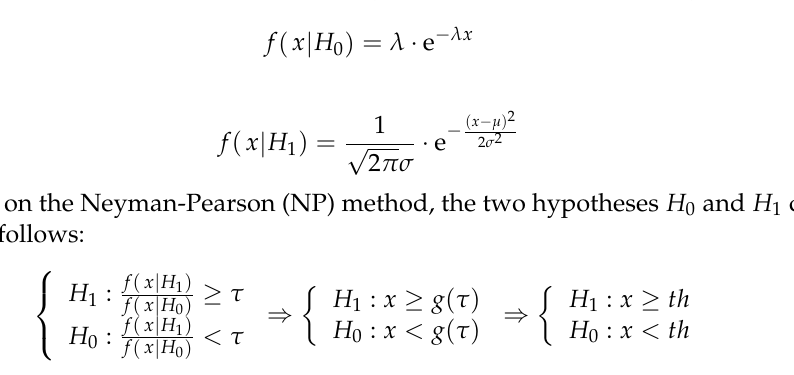
styles of lines with colors that are closed to Blue color to represent “Locating